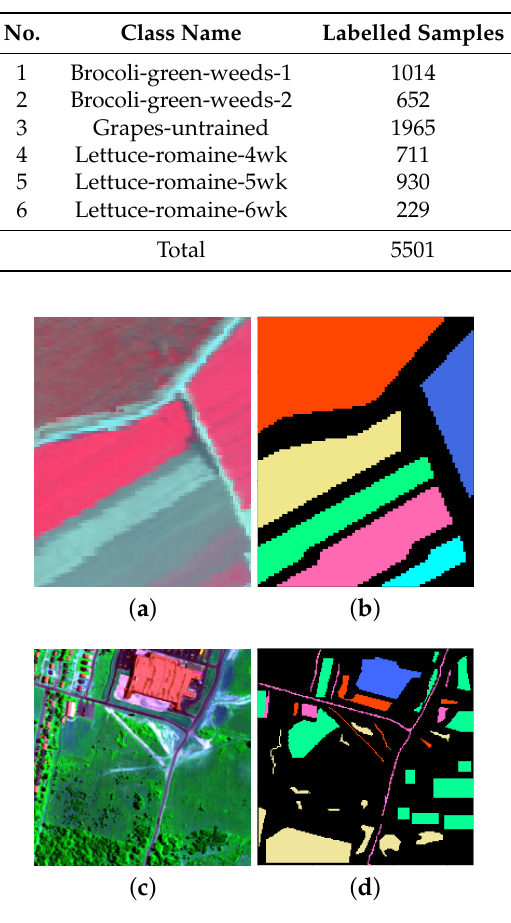
Figure 1. Two real hyperspectral data sets used in the experiments. ( a ) False color images of the selected part of Salinas Scene and ( b ) the corresponding ground truth classification. ( c ) False color image of the selected part of HYDICE Urban and ( d ) the corresponding ground truth